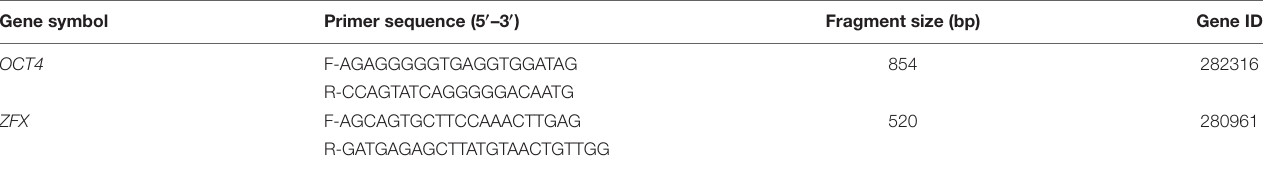
TABLE 1 | PCR primer sequences spanning the OCT4 and ZFX sgRNA target